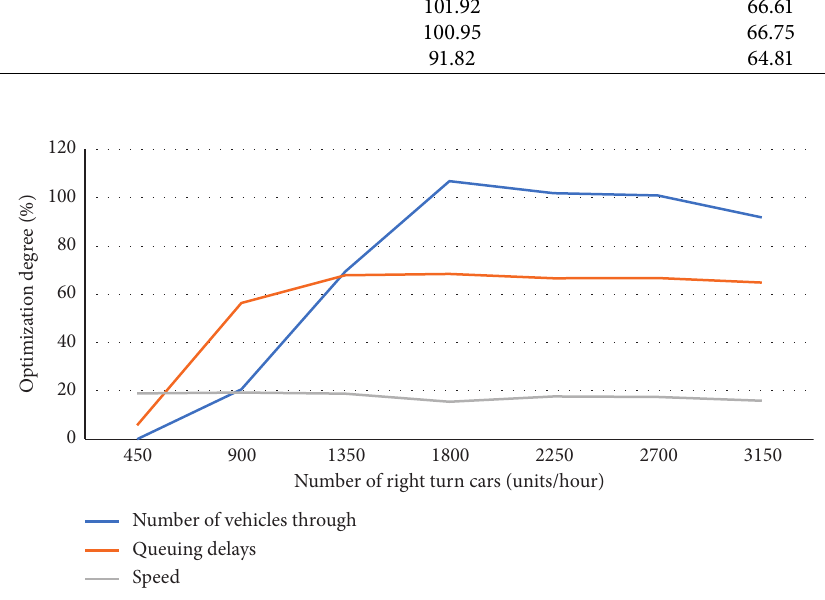
Figure 6: Influence of the number of right-turning vehicles on the optimization effect of scheme